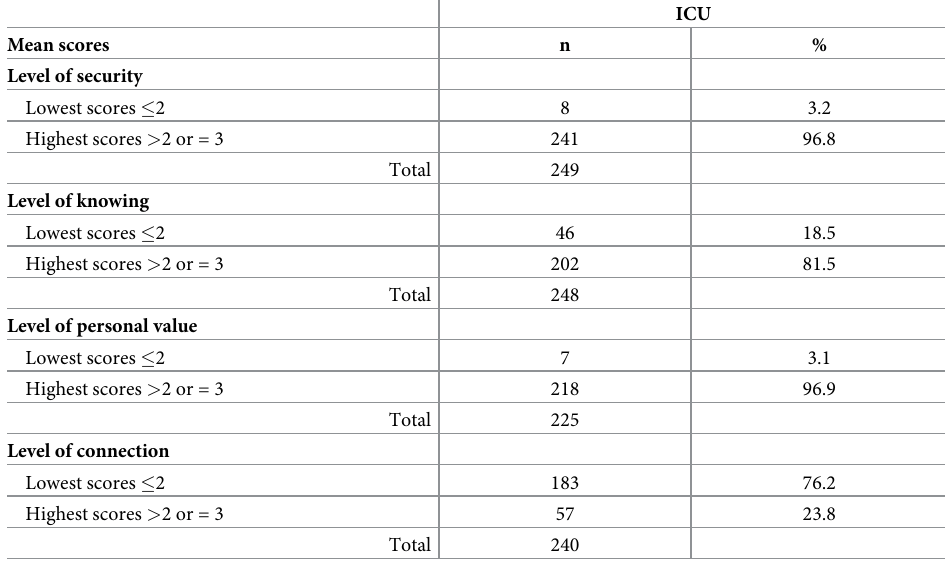
Table 8. Frequency and percentage of patients in each sub-scale split into two categories (low and high